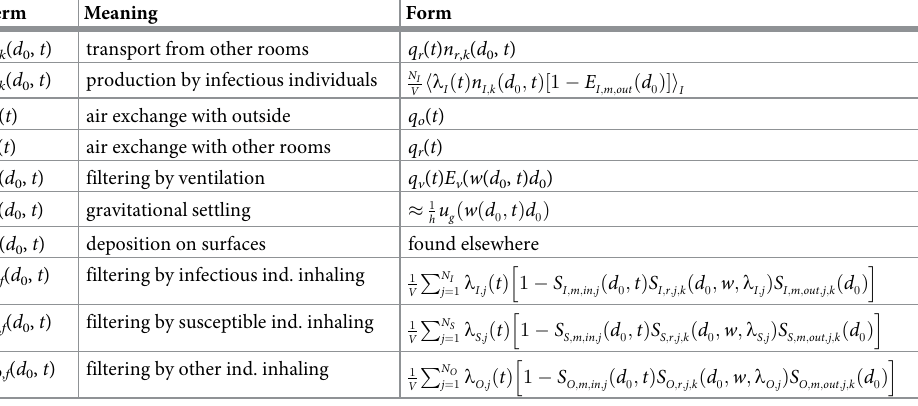
Table 1. Source and sink term summary. Summary of all the source (the β ) and sink (the α ) terms considered in this manuscript. “Individuals” is abbreviated as “ind.” See their relevant sections for details on where they come from and the meanings of their